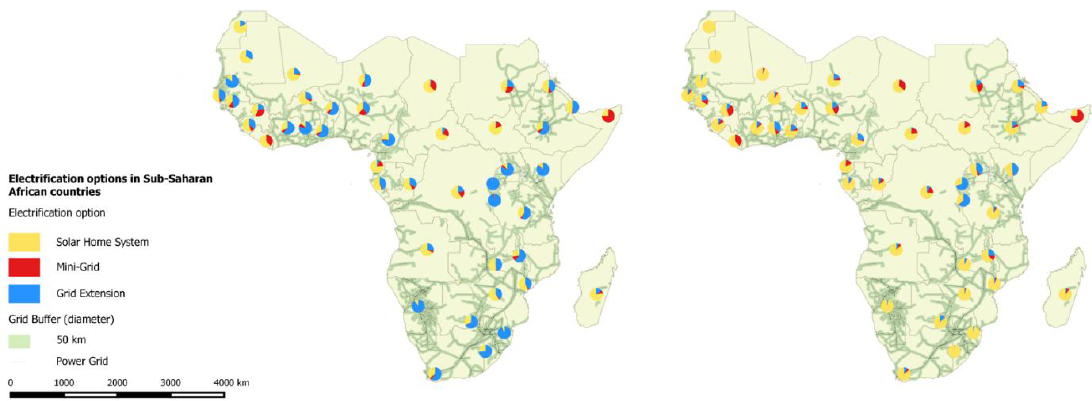
Figure 5. Geographic electrification options for excluding ( left ) and including ( right ) the population density within the grid buffer zone on basis of the existing grid infrastructure in sub-Saharan Africa.